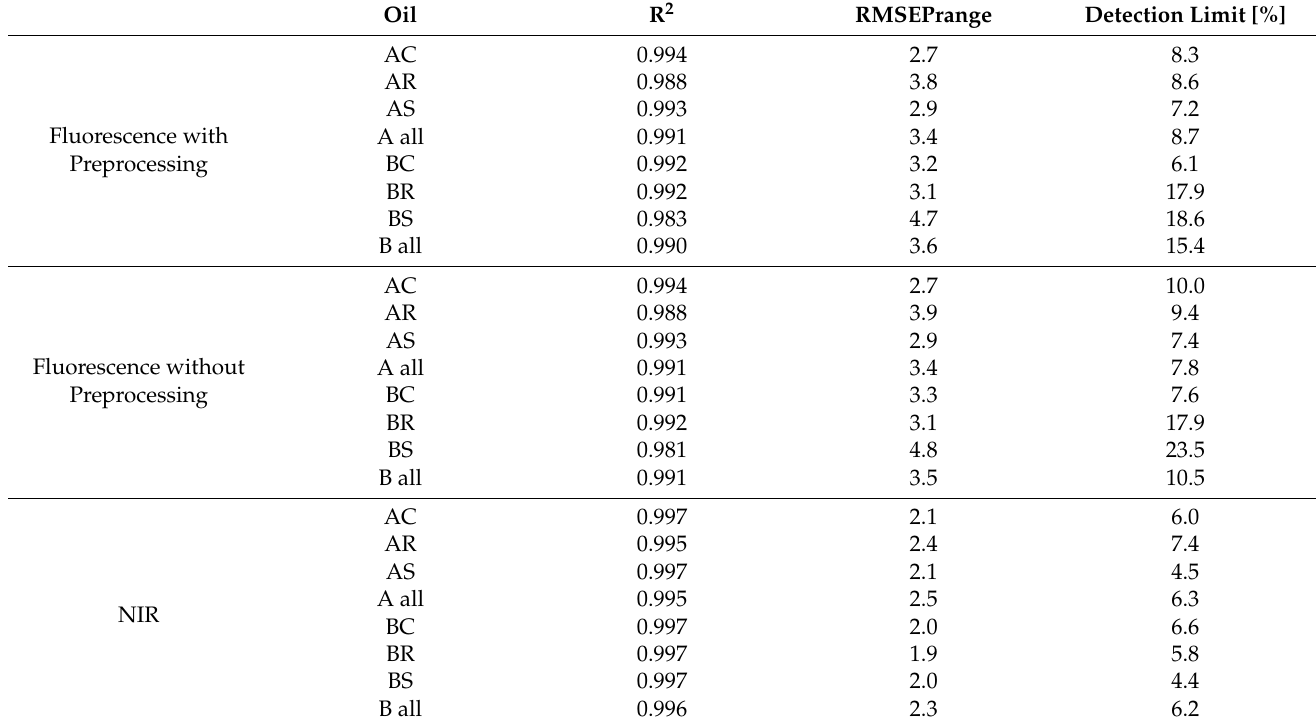
Table 6. Results of the best PLSR predictions for the single oils A and B with single evaluations of the adulteration oils R, S, and C and the combination of all adulterations with the samples all separately for all methods and the combination of all methods.